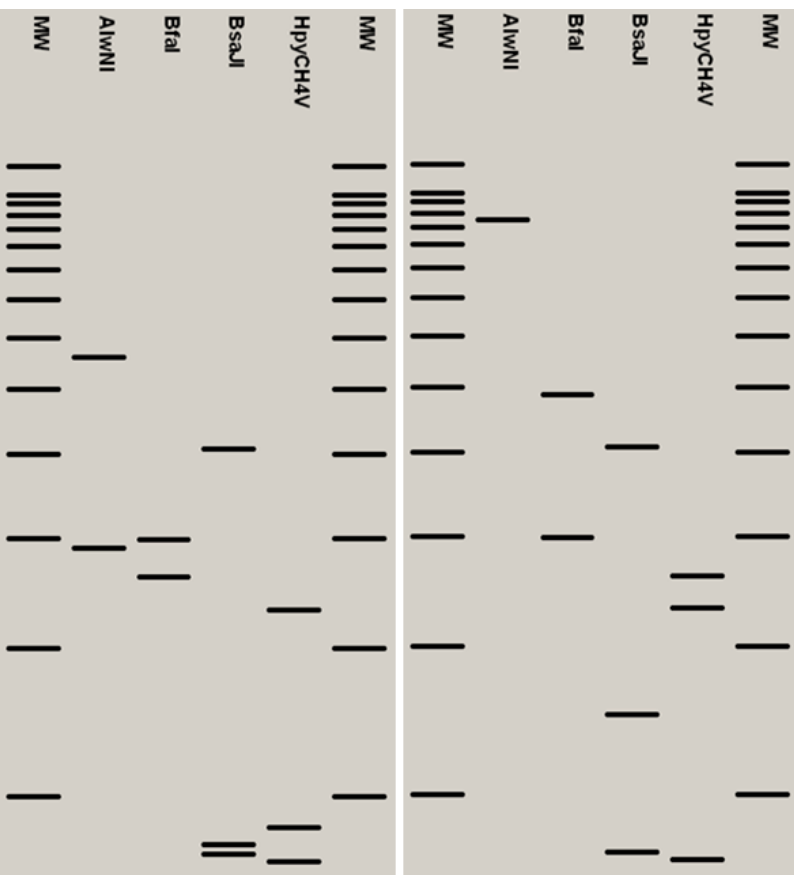
Figure 4. Virtual RFLP profiles generated by pDRAW32 software after digestion with Alw NI, Bfa I, Bsa JI, and Hpy CH4V restriction enzymes of 16S rDNA sequence KJ825886 from phytoplasma strain GN4 (left) and Y16389.1 (right). Line MW: Invitrogen 100 bp DNA Ladder, fragments size (bp) from top to bottom: 2072, 1500, 1400, 1300, 1200, 1100, 1000, 900, 800, 700, 600, 500, 400,